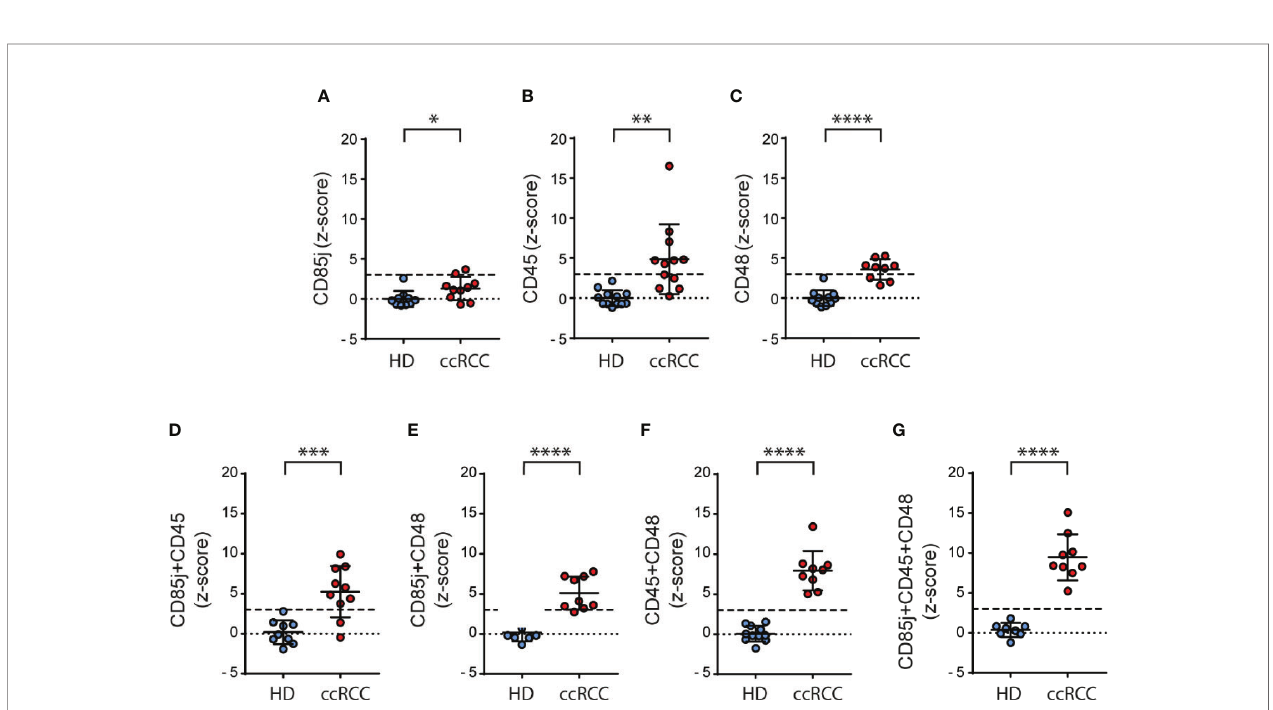
FIGURE 6 | Normalization of the expression of CD85j, CD45 and CD48 on NK cells signi fi cantly discriminates between ccRCC and HD samples. Normalization of the expression of CD85j, CD45 and CD48 in PBNK was performed calculating the respective z-scores and individual z-scores for CD85j (A) , CD45 (B) and CD48 (C) were depicted. Also, the sum of z-scores was calculated for the pairs of receptors CD85j and CD45 (D) , CD85j and CD48 (E) , and CD45 and CD48 (F) as well as the sum of z-scores of CD85j, CD45 and CD48 (G) . The dashed line in each graph indicates the value of the mean plus 3 SD. For HD: n =10 (A) , n =12 (B) , n =11 (C, F) , n =9 (D) and n =8 (E, G) . For P: n =10 (A, D) , n =12 (B) and n =9 (C, E – G) . * p < 0.05; ** p < 0.01; *** p < 0.001; **** p <